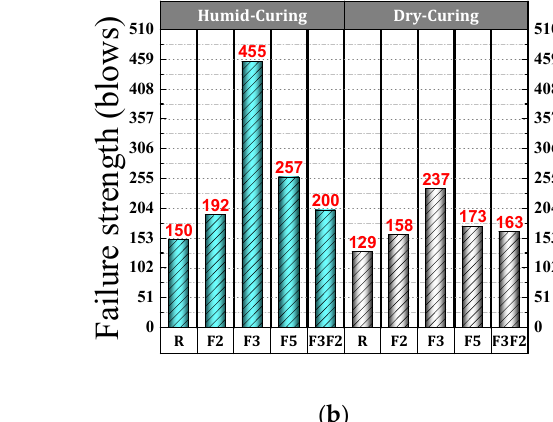
Figure 13. Normal probability plots for first crack (humid): ( a ) R, ( b ) F2, ( c ) F3. ) b ( ) a ( Figure 14. Distribution plots for first crack (humid): ( a ) F5, ( b ) F2F3. ) b ( ) a ( Figure 15. Normal probability plots for first crack (humid): ( a ) F5, ( b ) F2F3. ( c ) ( b ) ) a ( Figure 16. Distribution plots for first crack (dry): ( a ) R, ( b ) F2, ( c ) F3.